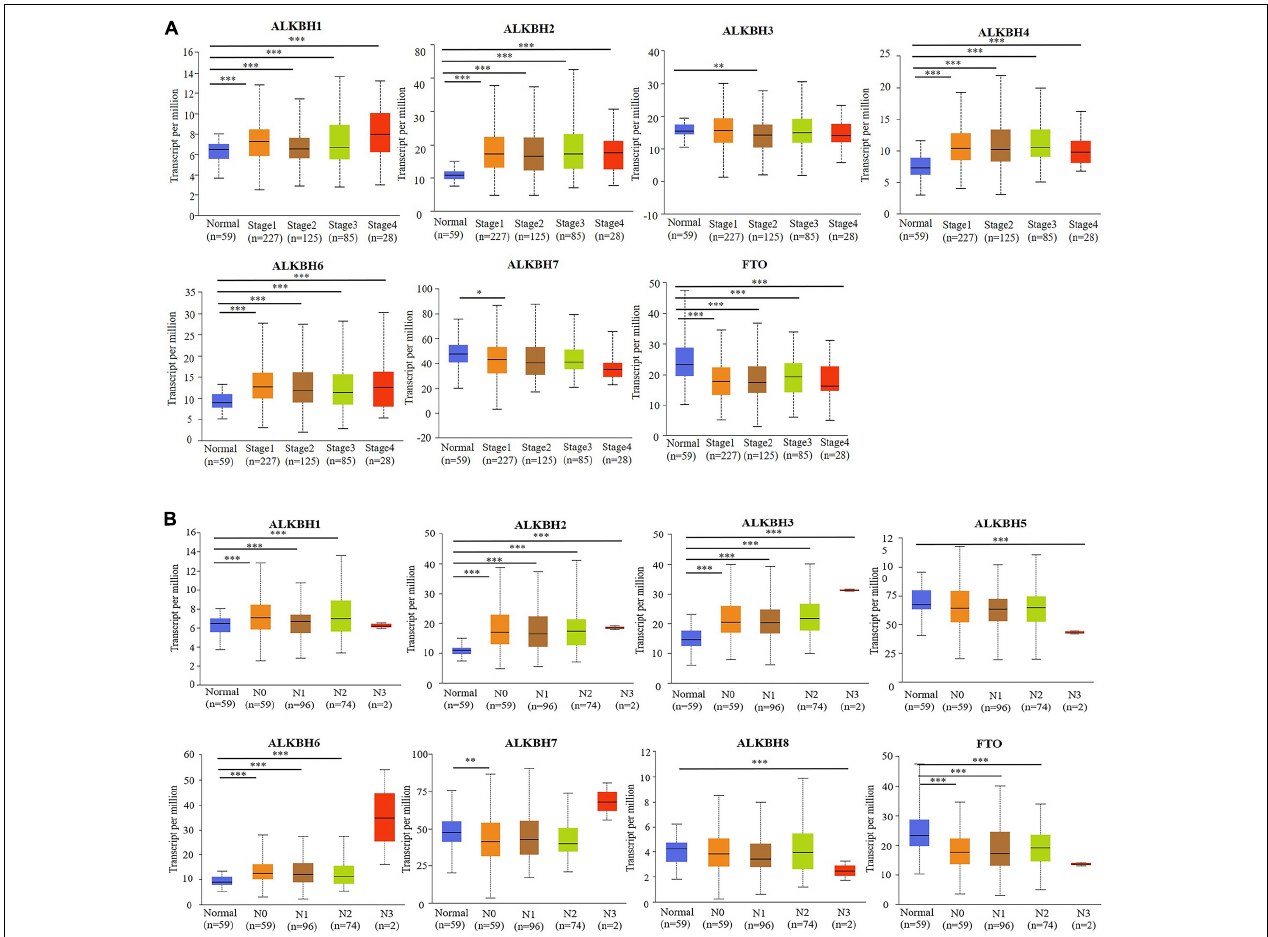
FIGURE 2 | (A) The relationship between mRNA expression and pathological stage of LUAD patients with different members of the AlkB family (UALCAN). (B) The relationship between mRNA expression of distinct AlkB family members with lymph node metastasis of LUAD patients (UALCAN). ∗ p < 0.05, ∗∗ p < 0.01, ∗∗∗ p <